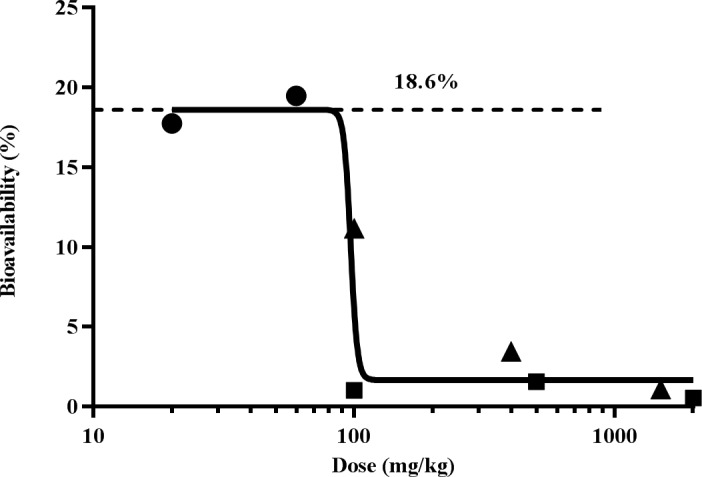
Log dose vs. oral bioavailability among mice (●), rats (■), and dogs (▲) showing the maximum extent of absorption of 18.6% at doses <100 mg/kg.